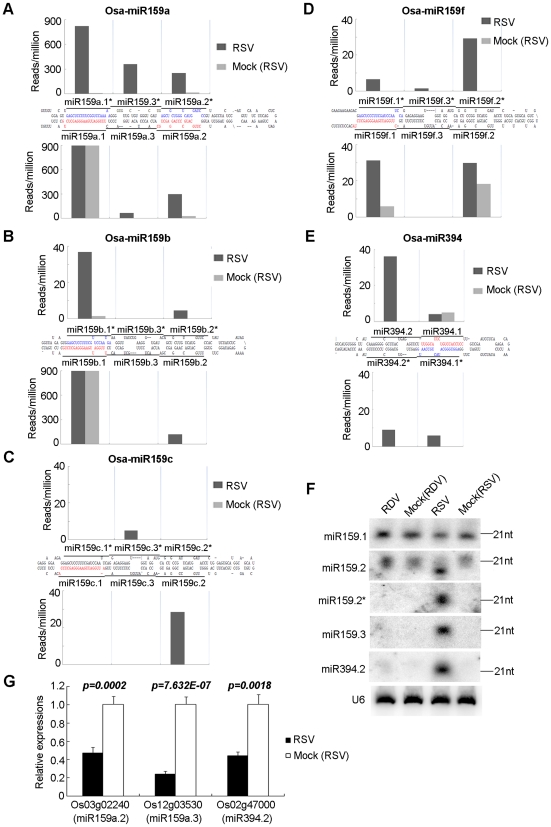
Phased miRNAs induced in RSV-infected rice.(A–E) Precursors of phased miRNAs. The sequences shown in red and blue are reported miRNAs and miRNA*s, respectively. The histograms indicate the reads of corresponding sequences on the precursors shown in black bars. (F) RNA gel blot showing the expression of phased miRNAs in RSV-infected rice. Rice U6 was reprobed as a control. (G) Expression analysis of the predicted targets of phased miRNAs by real time RT-PCR. Os03g02240 was previously validated as a target of miR159.2. [61]. Os12g03530 and Os02g4700 are predicted targets of miR159a.3 and miR394.2, respectively. The expression levels of the assayed genes were normalized to the expression level of OsEF-1α.